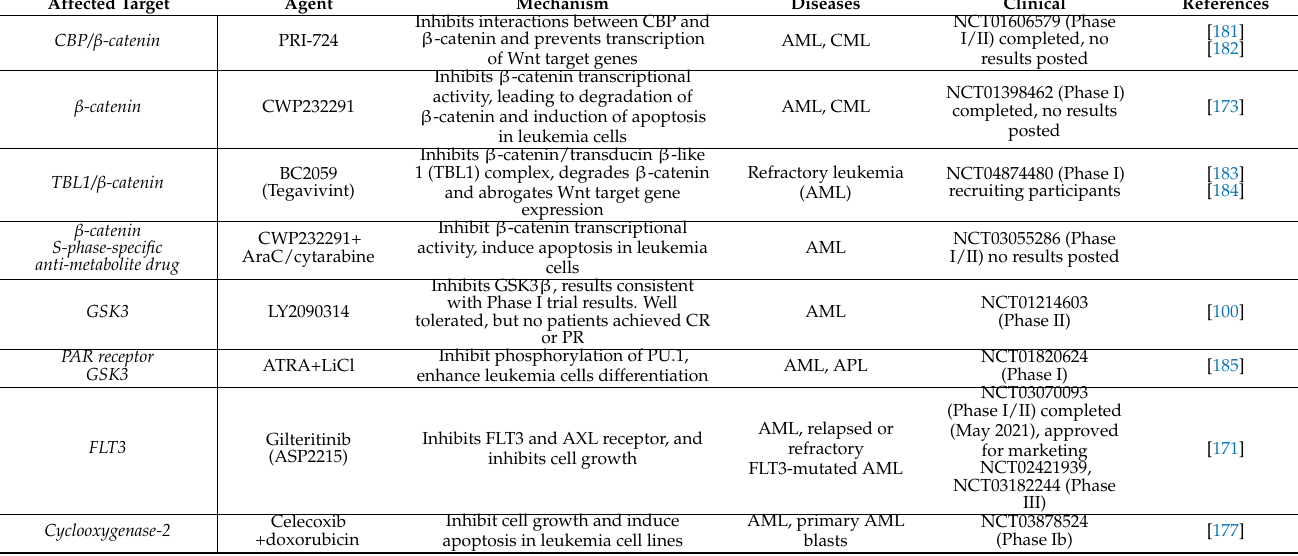
Table 3. Clinical trials involving Wnt signaling inhibitory/modulating compounds in AML.